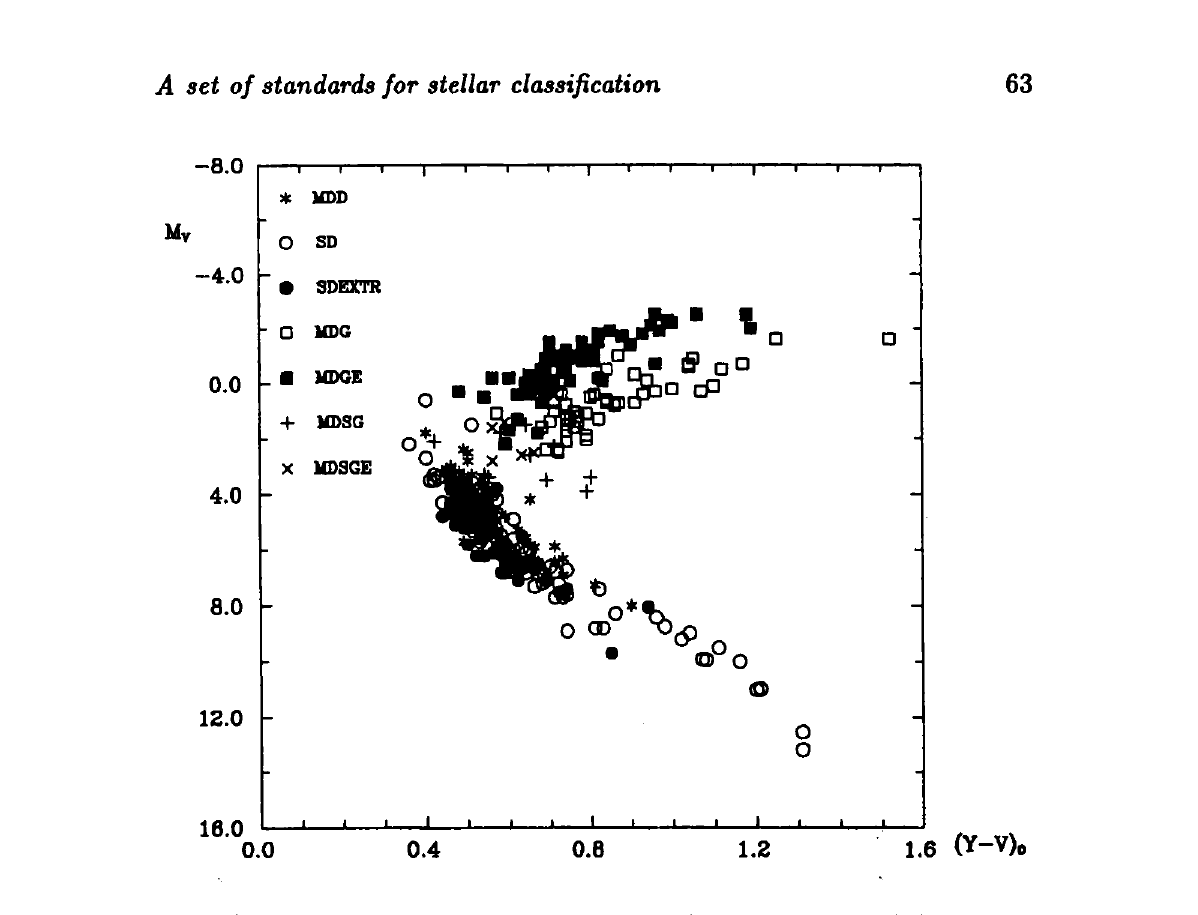
Fig. 2. The HR diagram for dwarfs with moderate metal deficiency, subdwarfs, metal-deficient giants and subgiants. (Y-V) o is the intrinsic colour index of the Vilnius photometric system, Afy is the absolute mag- nitude obtained from the literature sources described in Section